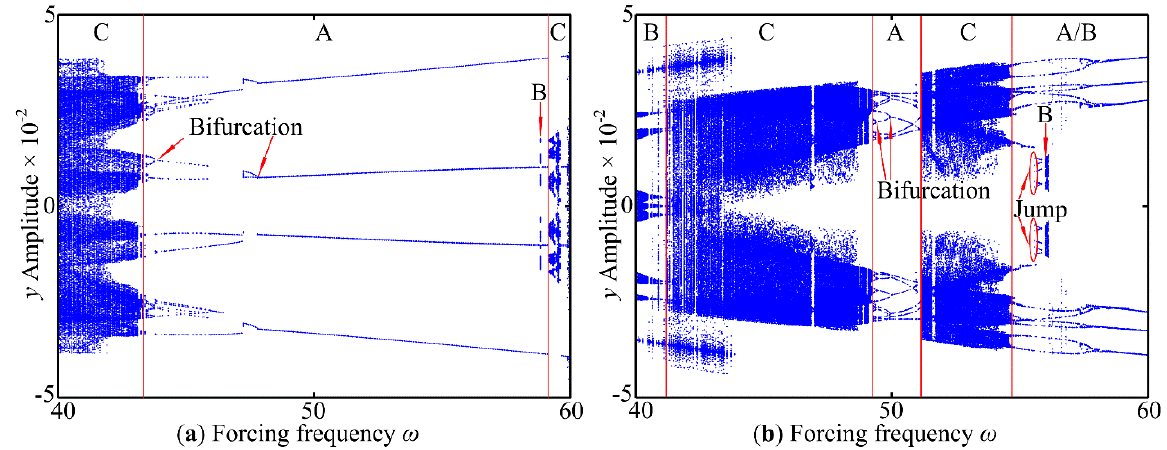
Figure 4. Bifurcation diagram of system response with ω , ( a ) k a = k b = 0; ( b ) k a = 2.8 × 10 5 , k b = 2 × 10 3 (A: periodic motion; B: quasi-periodic motion; C: chaotic motion).